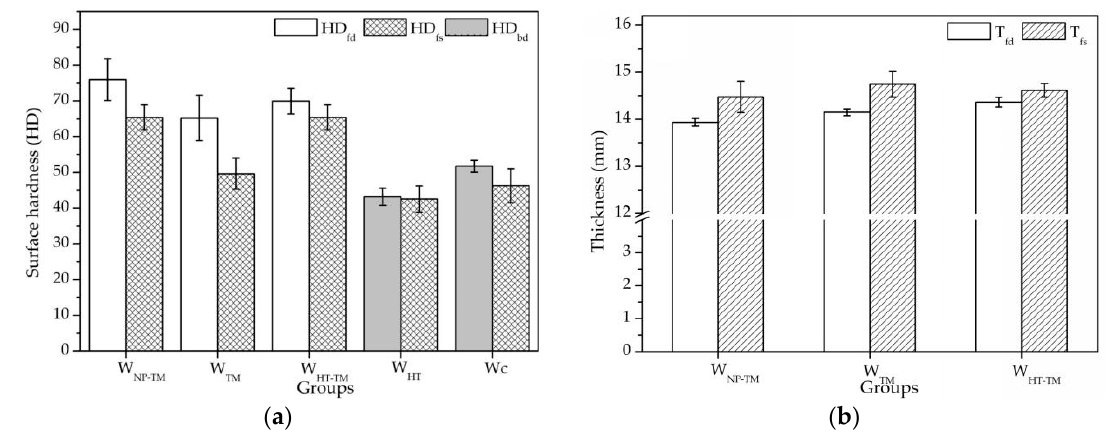
Figure 2. Surface hardness ( a ) and thickness changes ( b ) of selected samples.